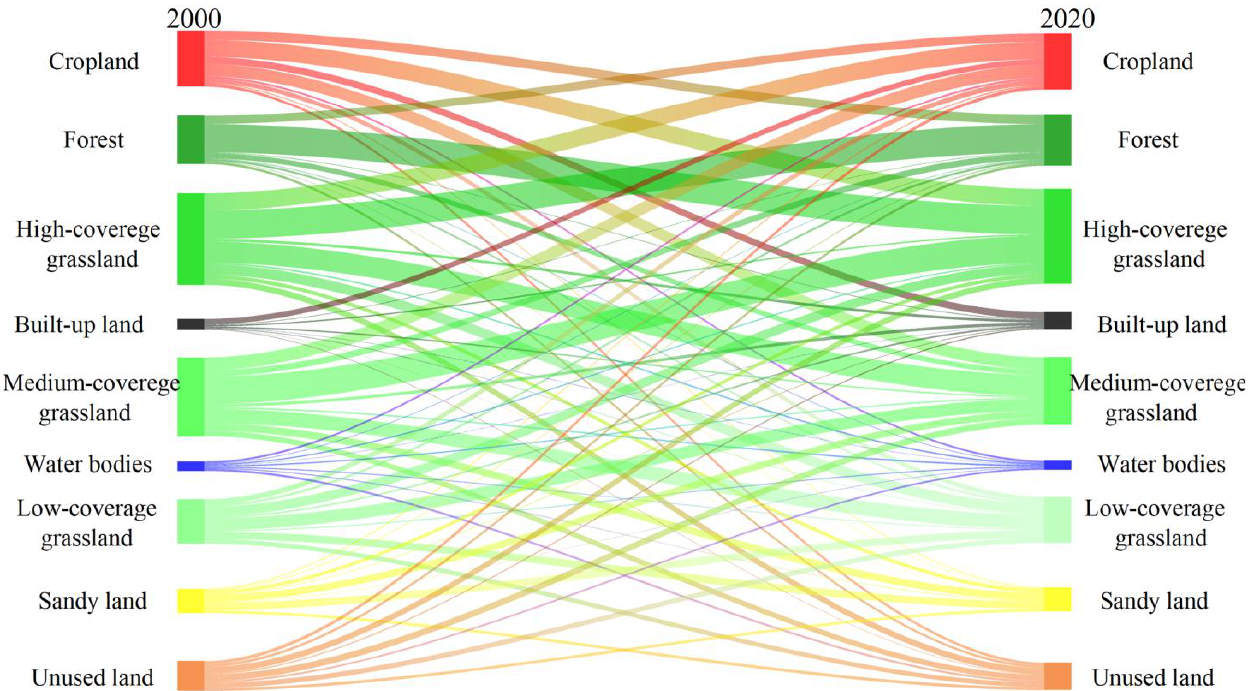
Figure 11. Sankey maps of land use transformations in Inner Mongolia from 2000 to 2020.